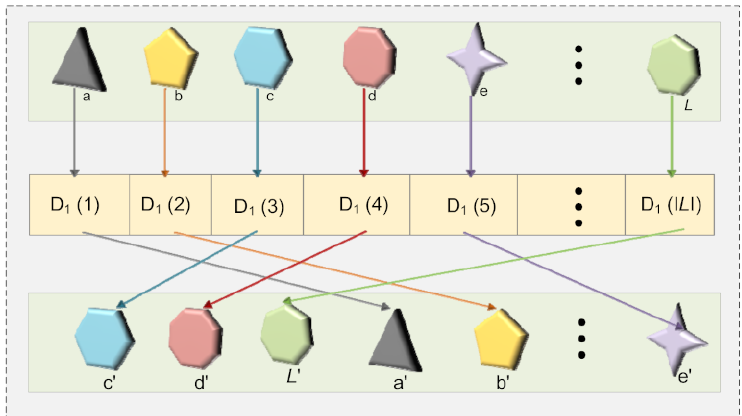
Figure 4. The traditional sequential scrambling process.